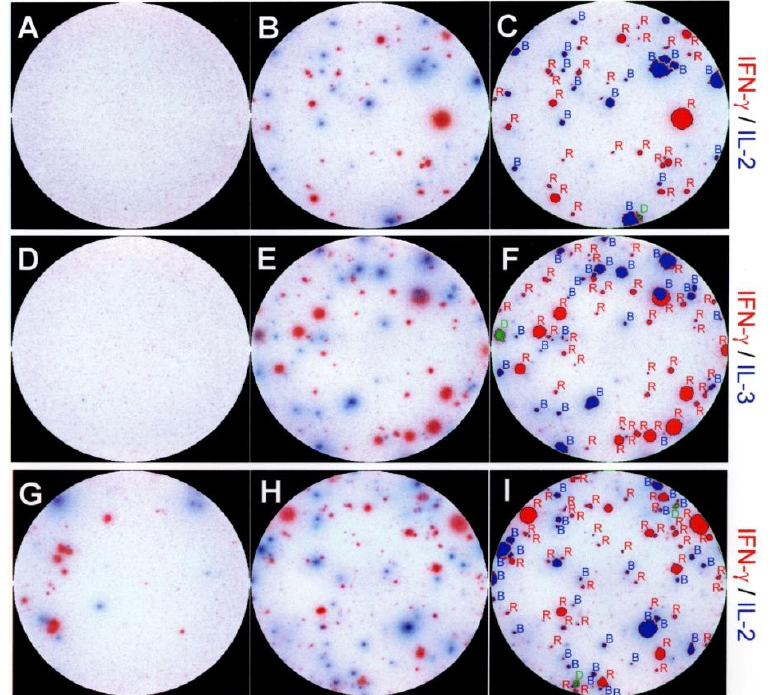
Figure 2. Representative images of double color ELISPOT wells showing dissociated production of interleukin (IL)-2, IL-3 and IFN- (cid:534)(cid:3)(cid:69)(cid:92)(cid:3)(cid:76)(cid:81)(cid:71)(cid:76)(cid:89)(cid:76)(cid:71)(cid:88)(cid:68)(cid:79)(cid:3)(cid:51)(cid:47)(cid:51)(cid:29)(cid:20)(cid:22)(cid:28) -151 specific CD4 cells. In panels (A-F) CD4 cells purified from dLN seven days after the immunization with PLP:139-151 peptide. In panels (G-I) freshly isolated spinal cord mononuclear cells were tested with naive splenic APC on day 21, during the second episode of paralytic EAE. The medium control wells are shown on the left (A,D,G), wells containing the PLP:139-151 peptide (at 20 (cid:80) M) are shown in the middle (B,E,H). The cytokine pair measured is specified on the right whereby the color of the substrate and the name of the cytokine are matched. The wells shown have been selected from serial dilutions of T cells; for better visual representation, they were also chosen to have optimal cell density and comparable numbers of red and blue spots. The result of two color image analysis of the peptide-stimulated wells (B,E,H) is shown in the panels on the right (C,F,I) as an overlay of the analyzed image and the original image. Single positive (blue or red spots) are outlined and labeled in red or blue, double positive spots are marked in green. Two color image analysis was performed as described previously [6] and in Experimental Section 4.3